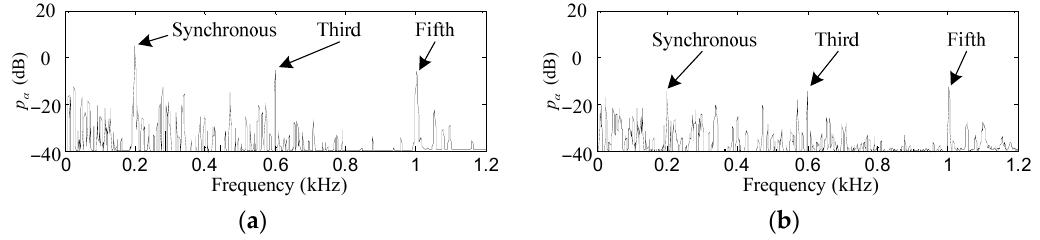
Figure 11. Experiment results of p α . ( a ) before harmonic torque elimination; ( b ) after harmonic torque elimination.